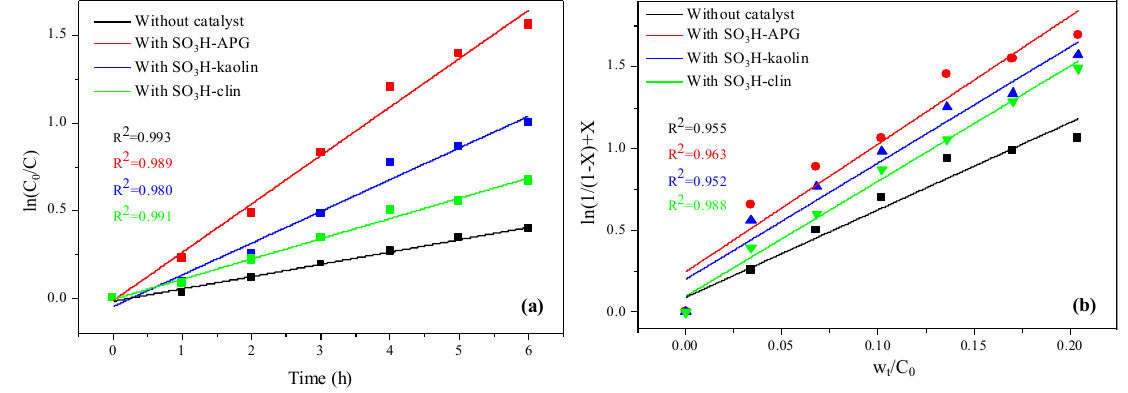
Figure 5. ( a ) First-order kinetic, ( b ) Langmuir–Hinshelwood (L-H) kinetics model fitted for cyclopentanone aldol condensation at different catalysts.